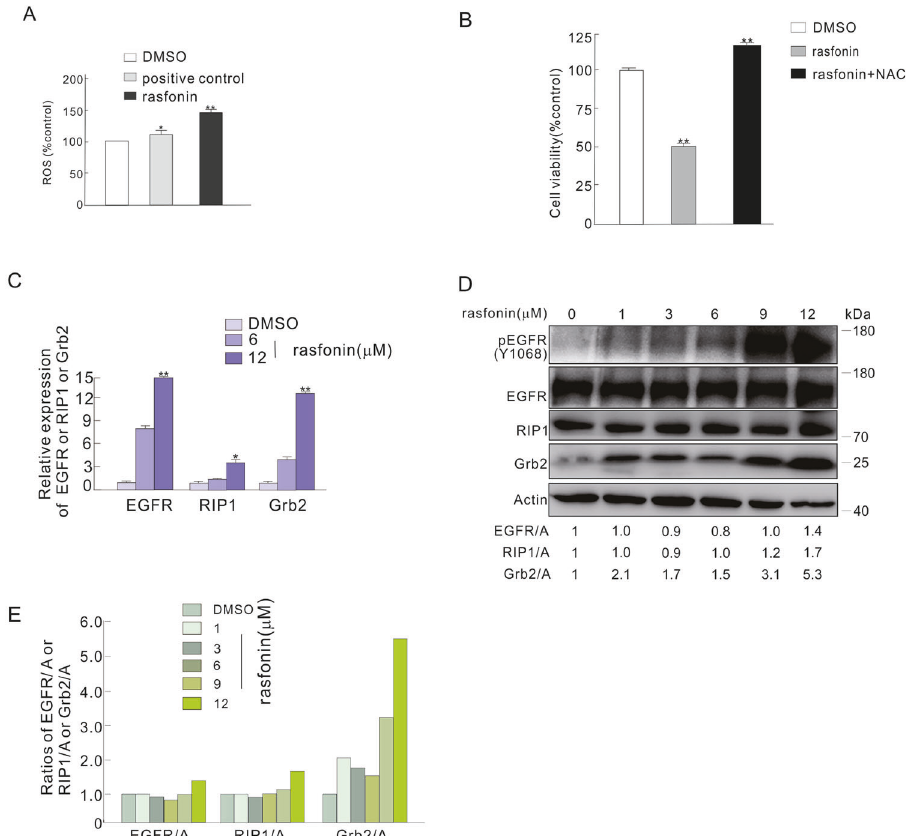
Fig. 3 Rasfonin increased the expression of EGFR, Grb2 and RIP1. A The level of reactive oxygen species (ROS) was detected as described in Materials and Methods following ACHN cells were treated with rasfonin (12 μ M) or positive control for 12 h. B ACHN cells were treated with rasfonin (12 μ M) in the presence or absence of N-acetyl-L-cysteine (NAC, 0.5 mM) for 12 h; cell viability was analyzed by MTS assay as described in Materials and Methods. C ACHN cells were challenged with rasfonin (6 and 12 μ M) for 4 h and then, the total RNA was extracted, reversed, and detected by real-time PCR. D , E ACHN cells were treated with rasfonin (0 – 12 μ M) for 4 h, the cells were lysed and subjected to immunoblotting with the antibodies indicated. Actin was used as a loading control. Data are presented as mean ± SD and are representatives of three independent experiments. Each performed in triplicate, and the data was analyzed by t -test. Single asterisk denotes that the group is statistically different from the control groups ( p < 0.05), whereas double asterisk means ( p < 0.01). The ratios between EGFR, RIP1 or Grb2 and Actin (A) were shown below the blots ( D ). Similar experiments were repeated at least three times.